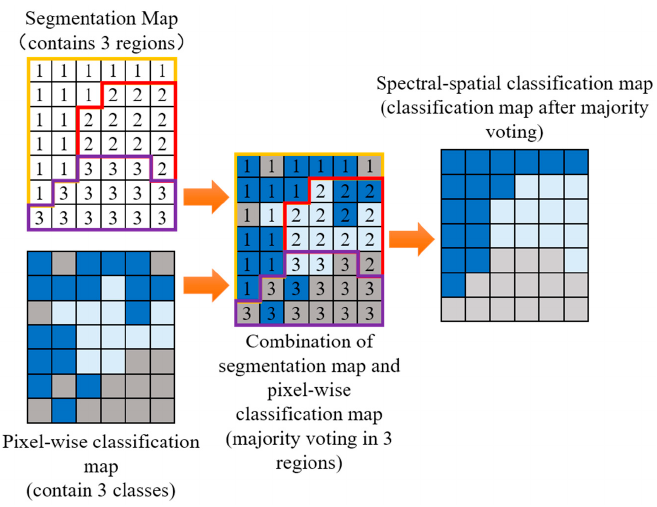
Figure 4. Schematic example of using majority voting within segmentation regions.